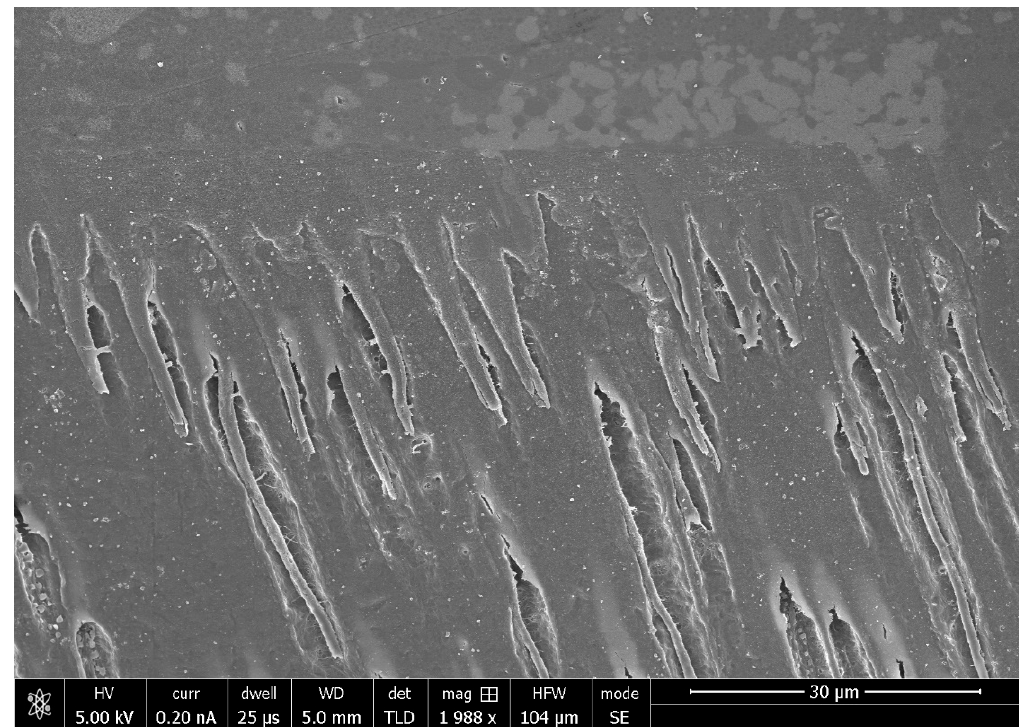
Figure 4. SEM micrograph of HA-containing adhesive demonstrating resin tag formation of varying depths. Reprinted with permission from Al-Hamdan et al. [33]. Copyright 2020 MDPI.